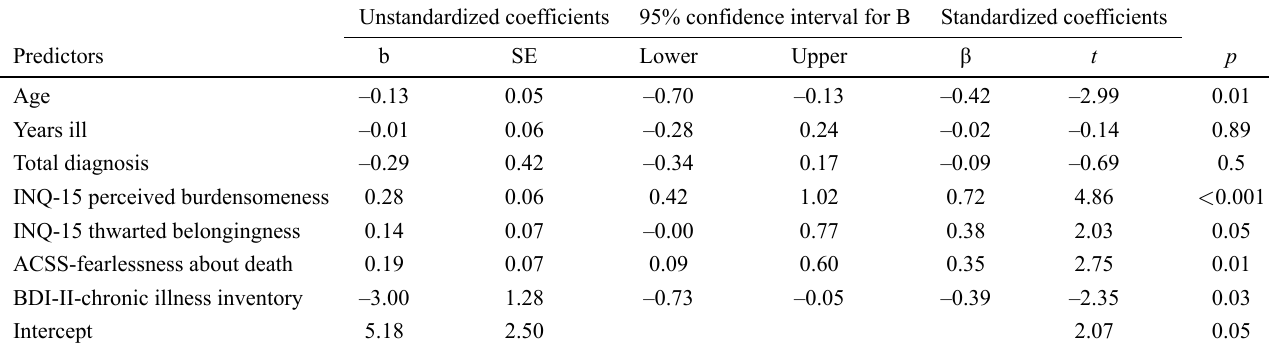
Table 4. Multiple linear regression analysis results (n =